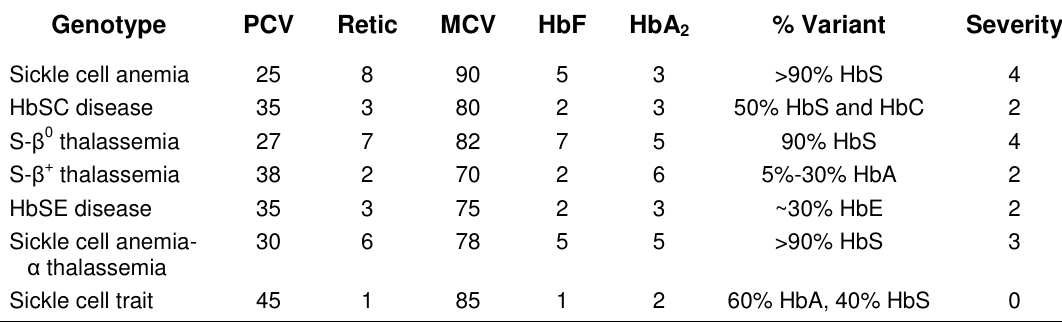
Clinical and Hematological Features of Some Sickle